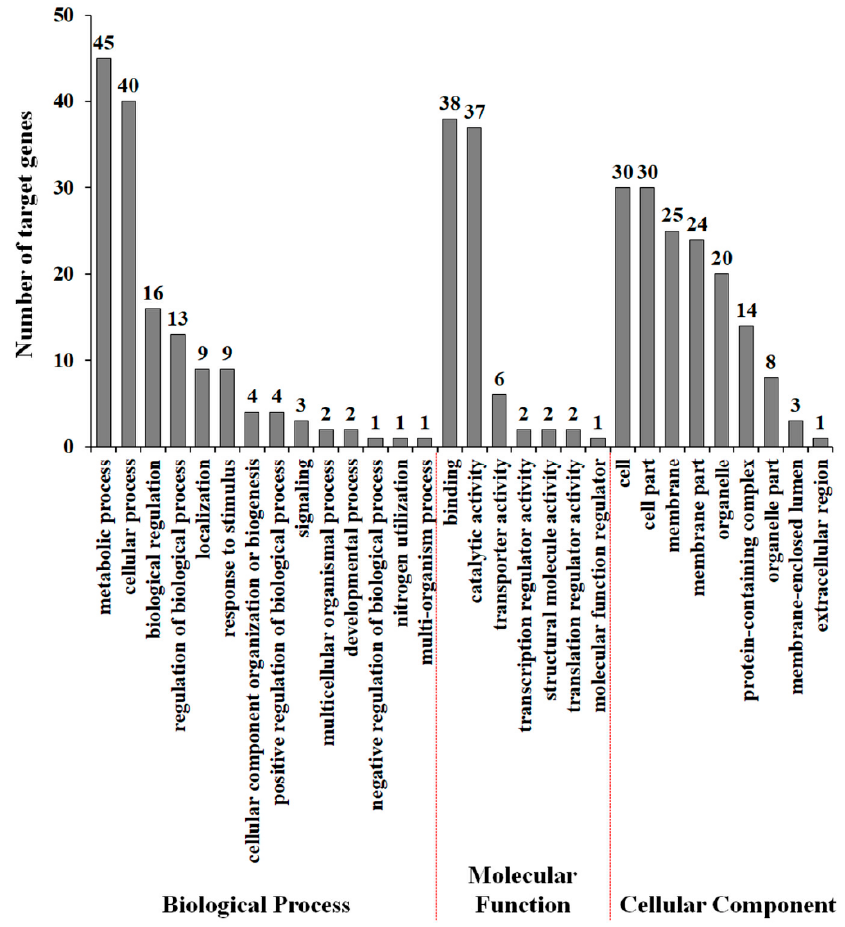
Figure 4. Gene ontology classification of lncRNA target genes. The results are summarized in three main categories: biological process, molecular function, and cellular component.